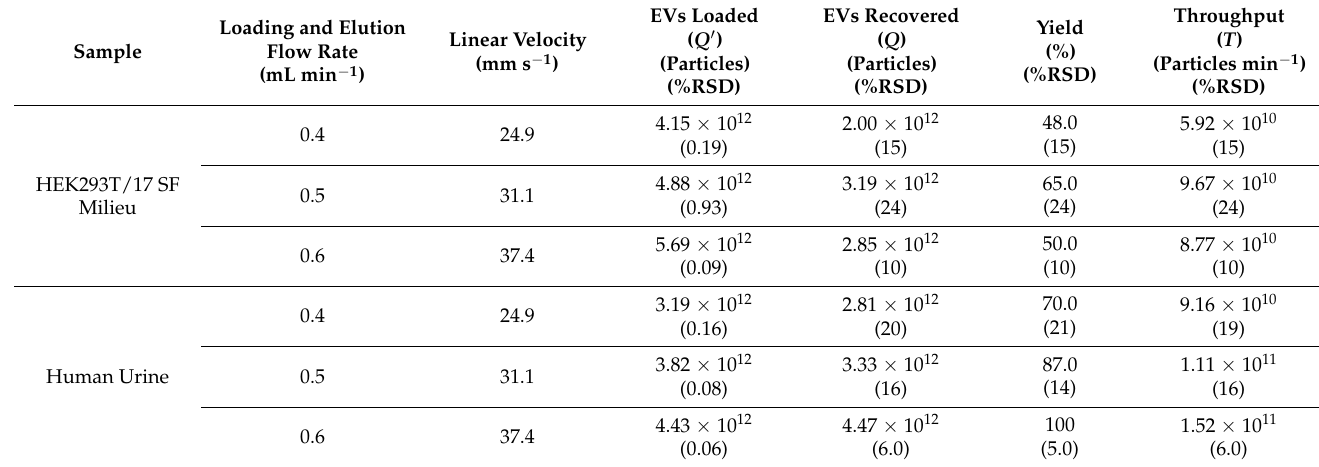
Table 2. The effect of varying loading and elution flow rates on the loading, recovery, throughput, and yield of EVs isolated from HEK293T/17 SF milieu and human